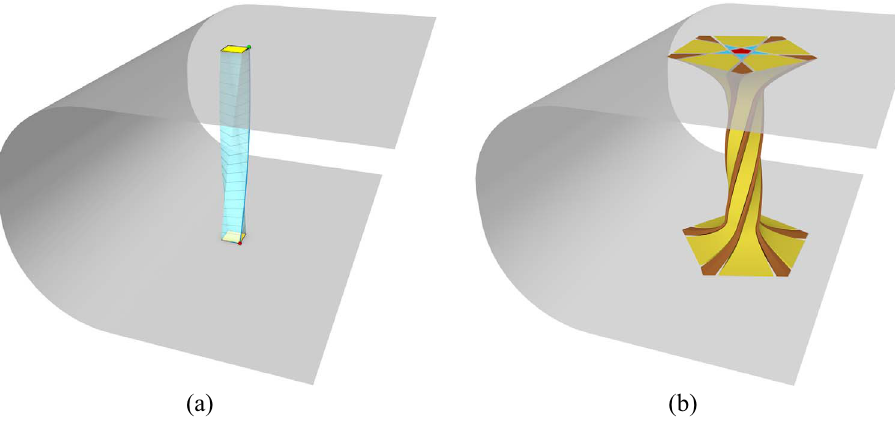
Figure 13. Partial or complete GML bodies, with cross sections in